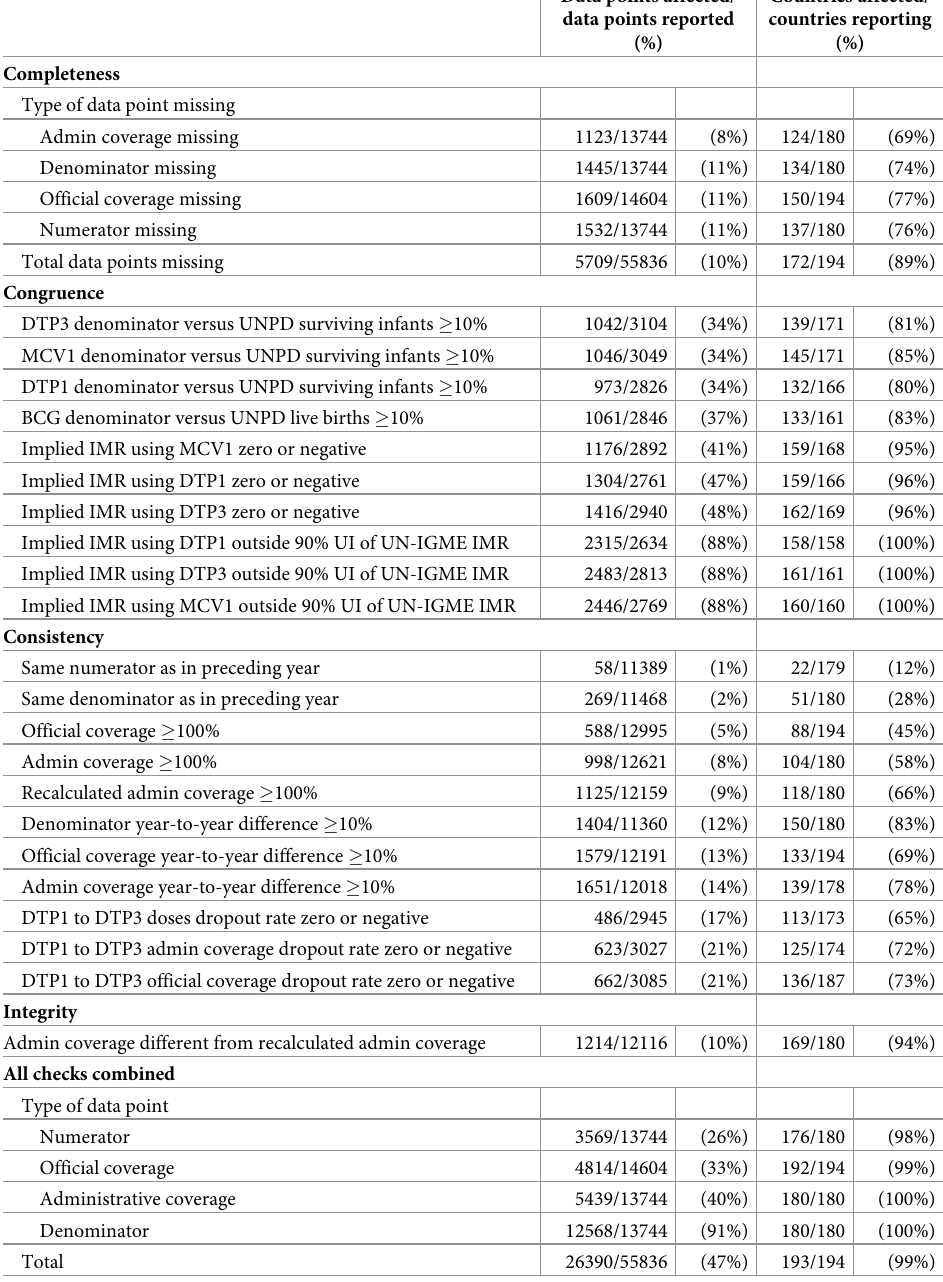
Table 2. Immunization coverage data points and reporting countries affected by potential data quality issues, by dimension of data quality, 194 WHO Member States,